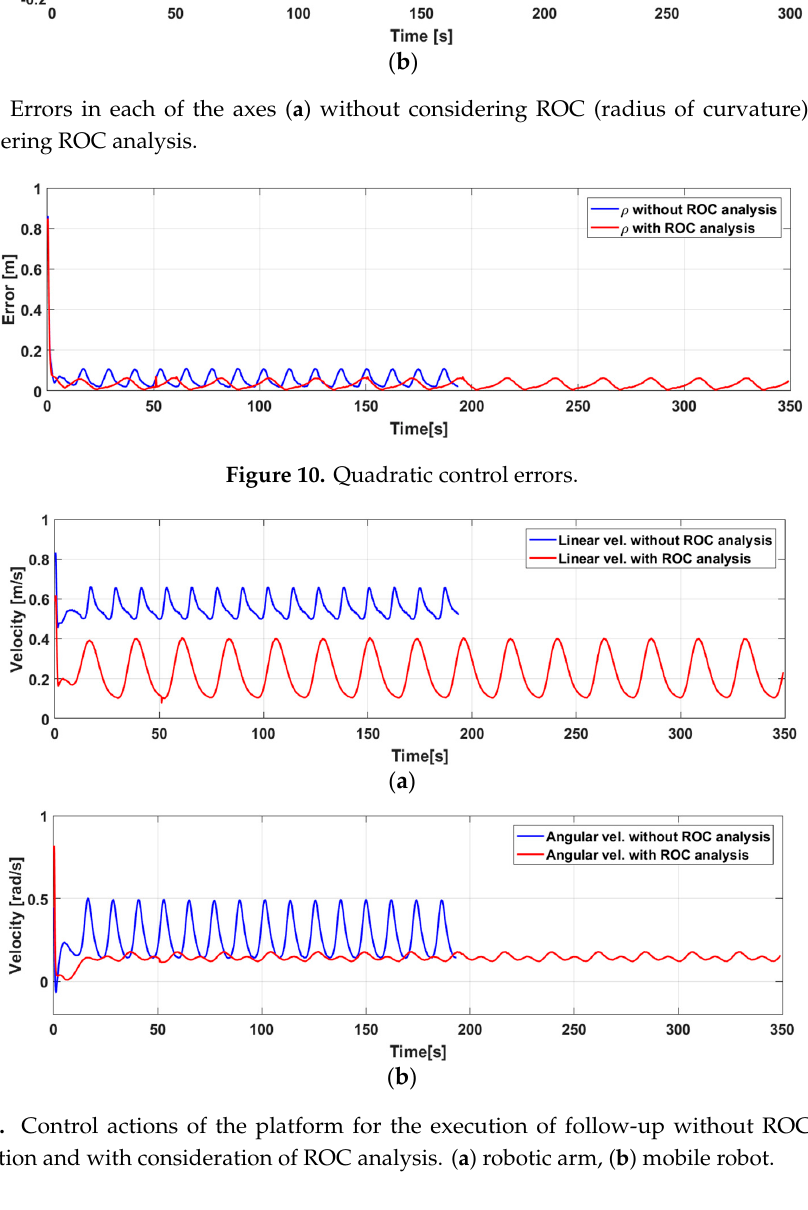
Figure 11. Control actions of the platform for the execution of follow ‐ up without ROC analysis consideration and with consideration of ROC analysis. ( a ) robotic arm, ( b ) mobile robot. The strobe movement of the robotic system makes it possible to determine the resulting execution by applying both controllers. Through an upper view, Figure 12 shows the comparison between the strobe movement of the robotic system without consideration of the curvature radius analysis and with the consideration of the curvature radius analysis, differentiating the path of the platform and the movements executed by the robotic arm. The Figure 13 also presents a stroboscopic view of the movements executed by the robot in space.